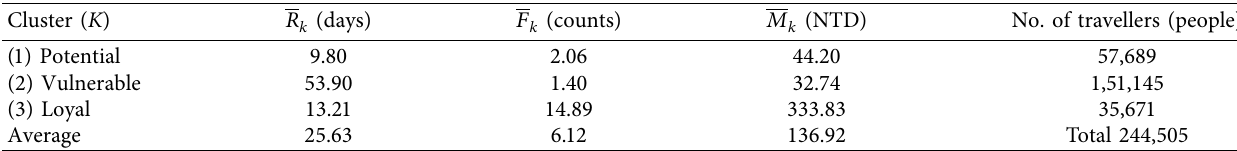
Table 10: Clustering results by K -means for 2018 Q 2.